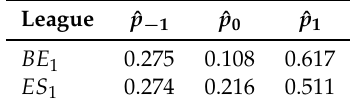
Table 2. Estimated probabilities in the 2016/2017